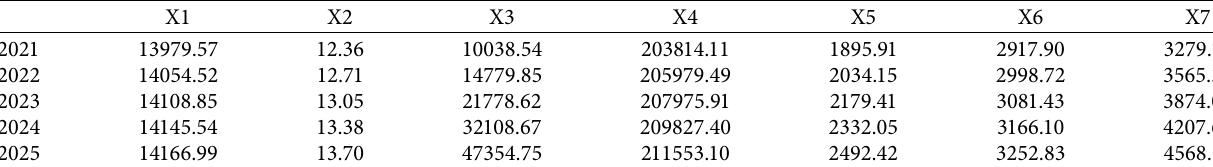
Table 10: Predicted values of logistics indices.